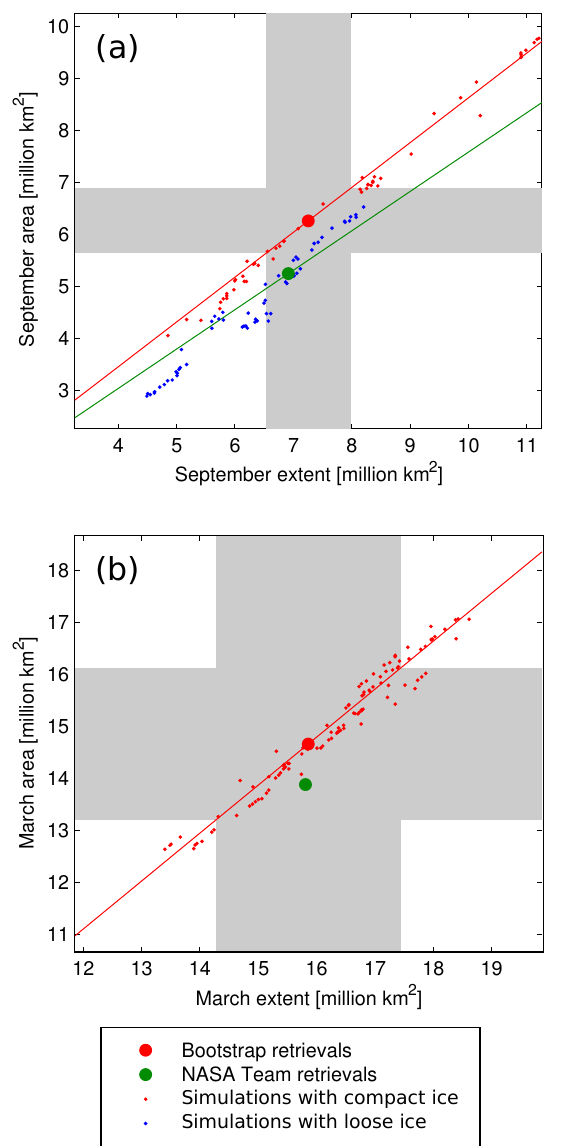
Fig. 6. (a) September and (b) March sea-ice area vs. sea-ice extent in models and satellite retrievals. The red line connects all value pairs that have the same percentage bias in sea-ice extent and in sea-ice area relative to the Bootstrap retrievals. The gray shading indicates a ± 10% range around the values obtained from the Boot- strap retrievals. Note that in March all simulations have compact ice, which is why there are no blue dots in (b) .